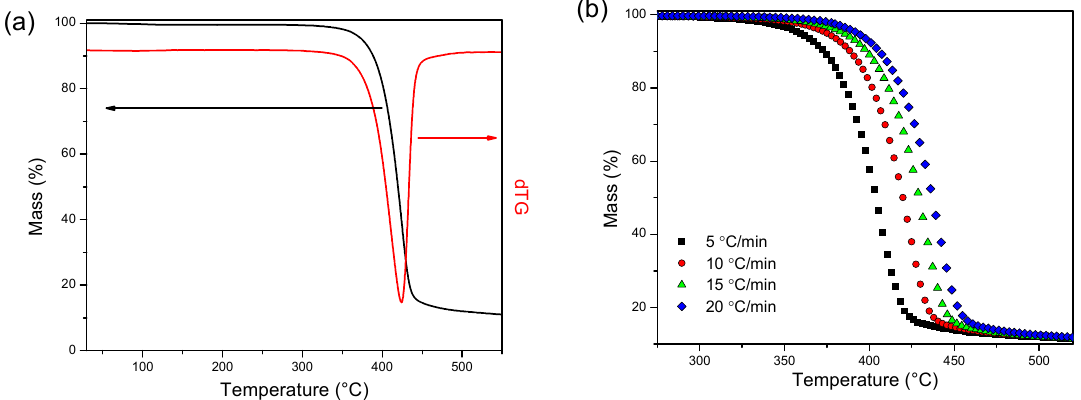
Figure 12. ( a ) Mass loss curve and dTG of PEV at 10 °C/min in N 2 , ( b ) Mass loss curves of PEV under multiple heating rates.